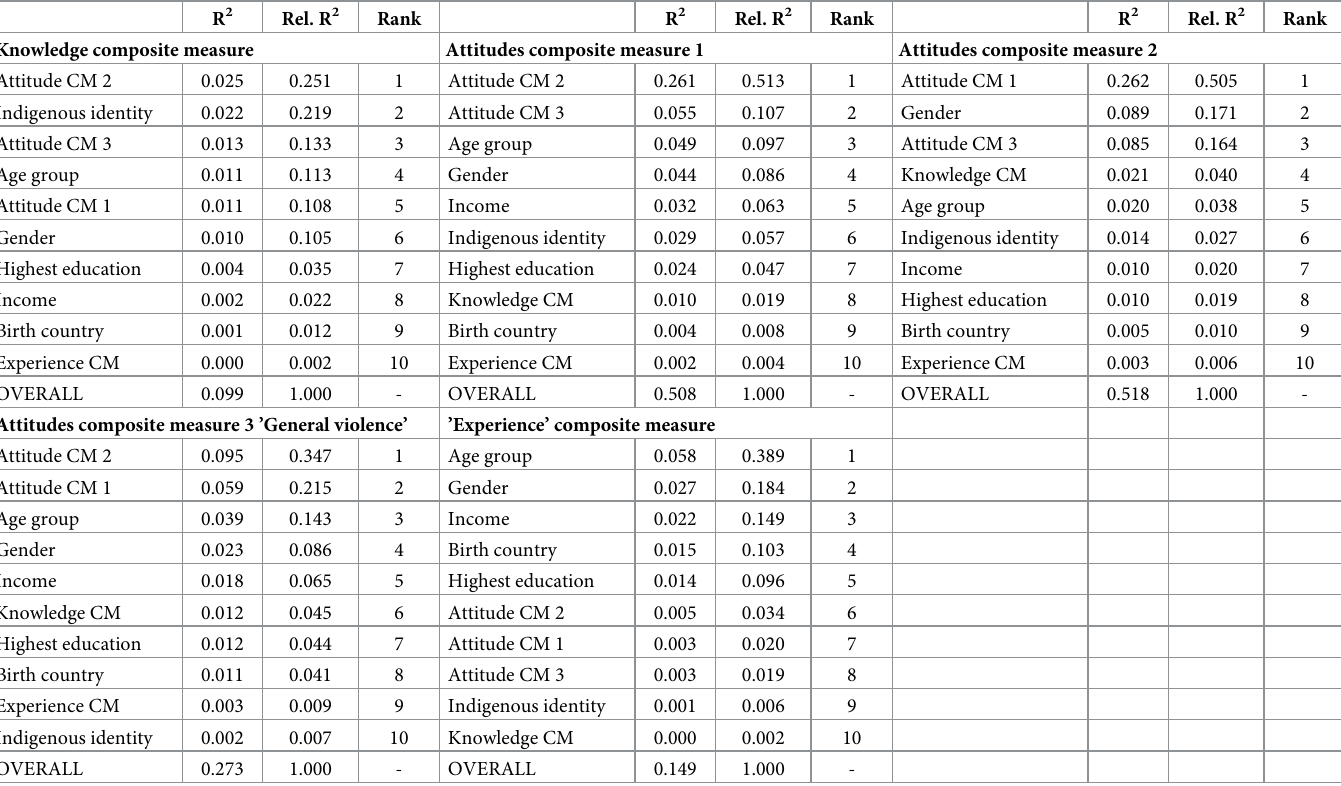
Table 5. Relative importance * of covariates in predicting responses to composite